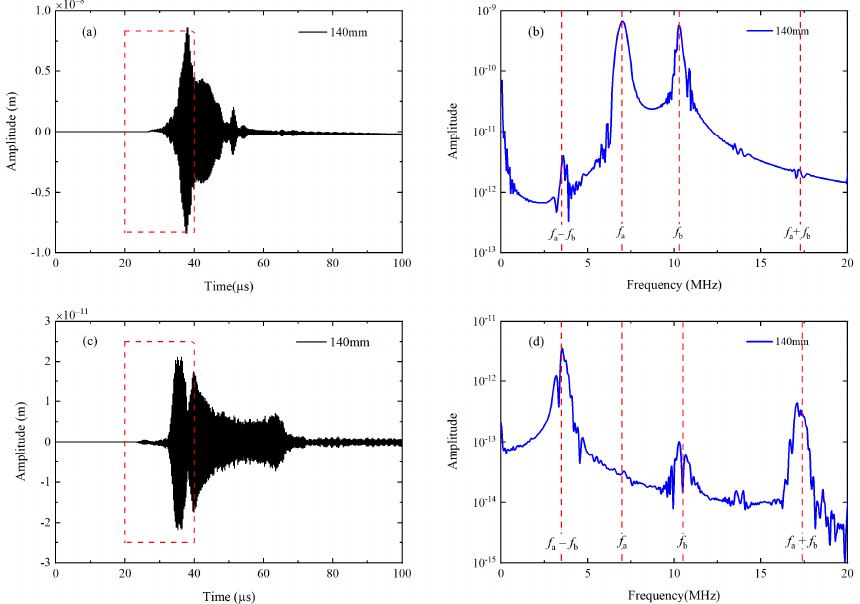
Figure 6. As for the second mode triplet in simulations, typical time-domain waveforms at x = 140 x = 140 mm ( a ) within the time window (during 20 µ s and 40 µ s) are transferred into mm ( a ) within the time window (during 20 μ s and 40 μ s) are transferred into frequency domain ( b ) via the FFT; In addition, a group of time-domain signals within the time window (from 20 μ s to 40 μ s) are processed by the pulse-inversion technique ( c ) and the FFT ( d ).